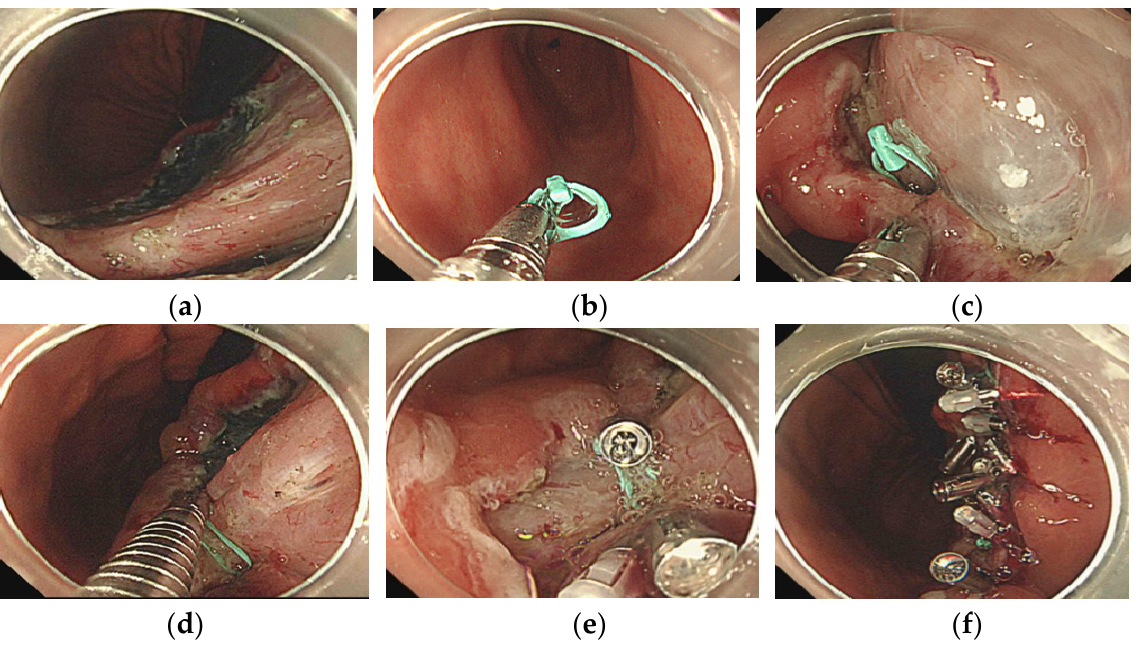
Figure 2. ( a ) A gastric angle mucosal defect occurred subsequent to endoscopic submucosal dissection. ( b ) SureClip with the loop is delivered to the mucosal defect. ( c ) SureClip with the loop